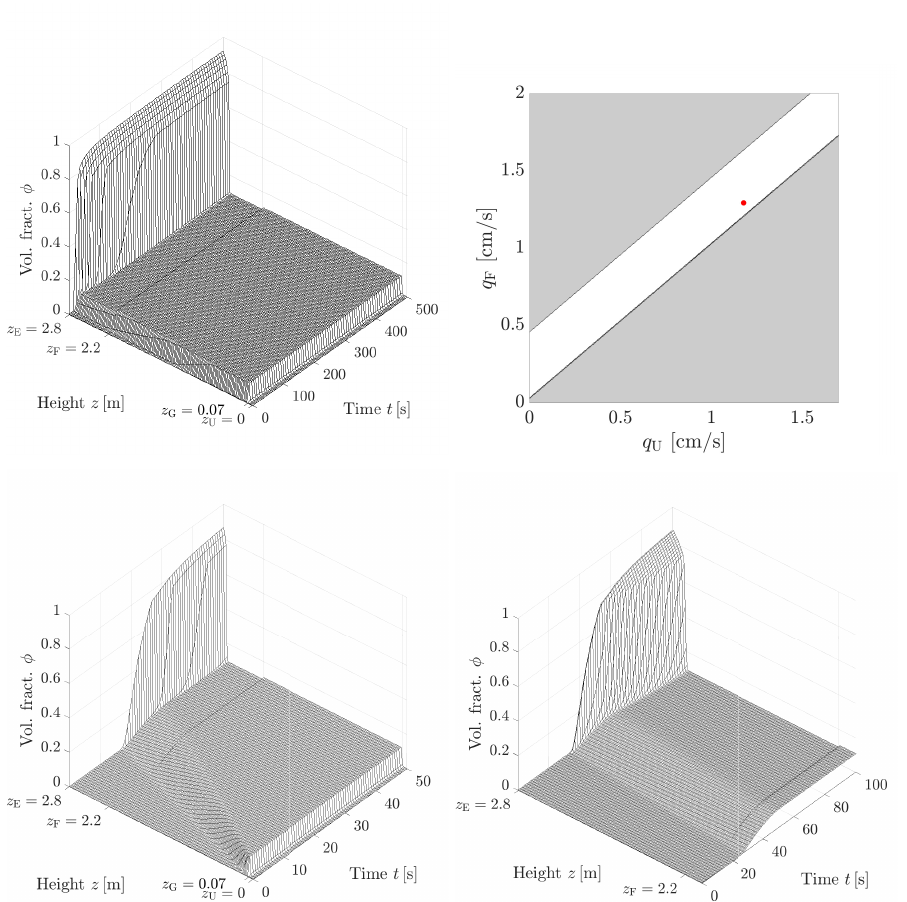
Figure 12. First row: Numerical simulation of a fill-up process ( left ) and operating chart ( right ) of the model with parameter values of Experiment 1 and bulk velocities ( q U , q F ) = ( 1.178,1.292 ) cm/s, which is the red point inside the white region. Second row: Zoom in time of the fill-up process during the first 50s ( left ) and a zoom in space showing the top of the column, where the foam formation in zone 3 is clearly seen during the first 100s ( right